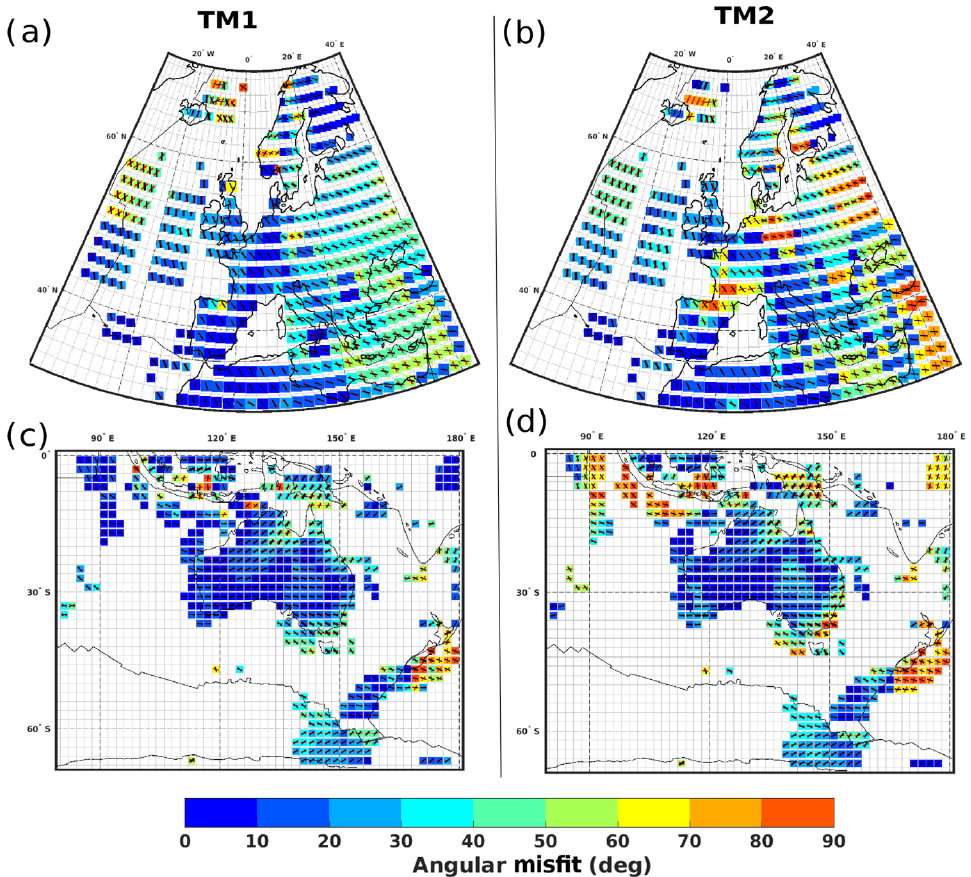
Figure 7. Regional comparison of the angular misfit in Europe (a, b) and Australia (c, d) between the observed and modeled total stresses with TM1 (a, c) and TM2 (b, d) . Red bars denote modeled orientations versus black bars showing the smoothed observed stress field